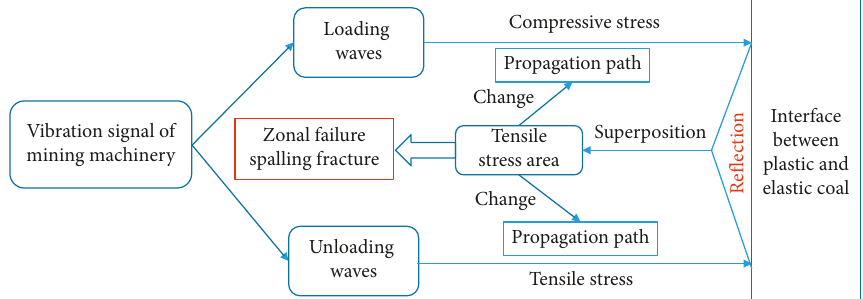
Figure 6: Theoretical model of coal wall dynamic damage.